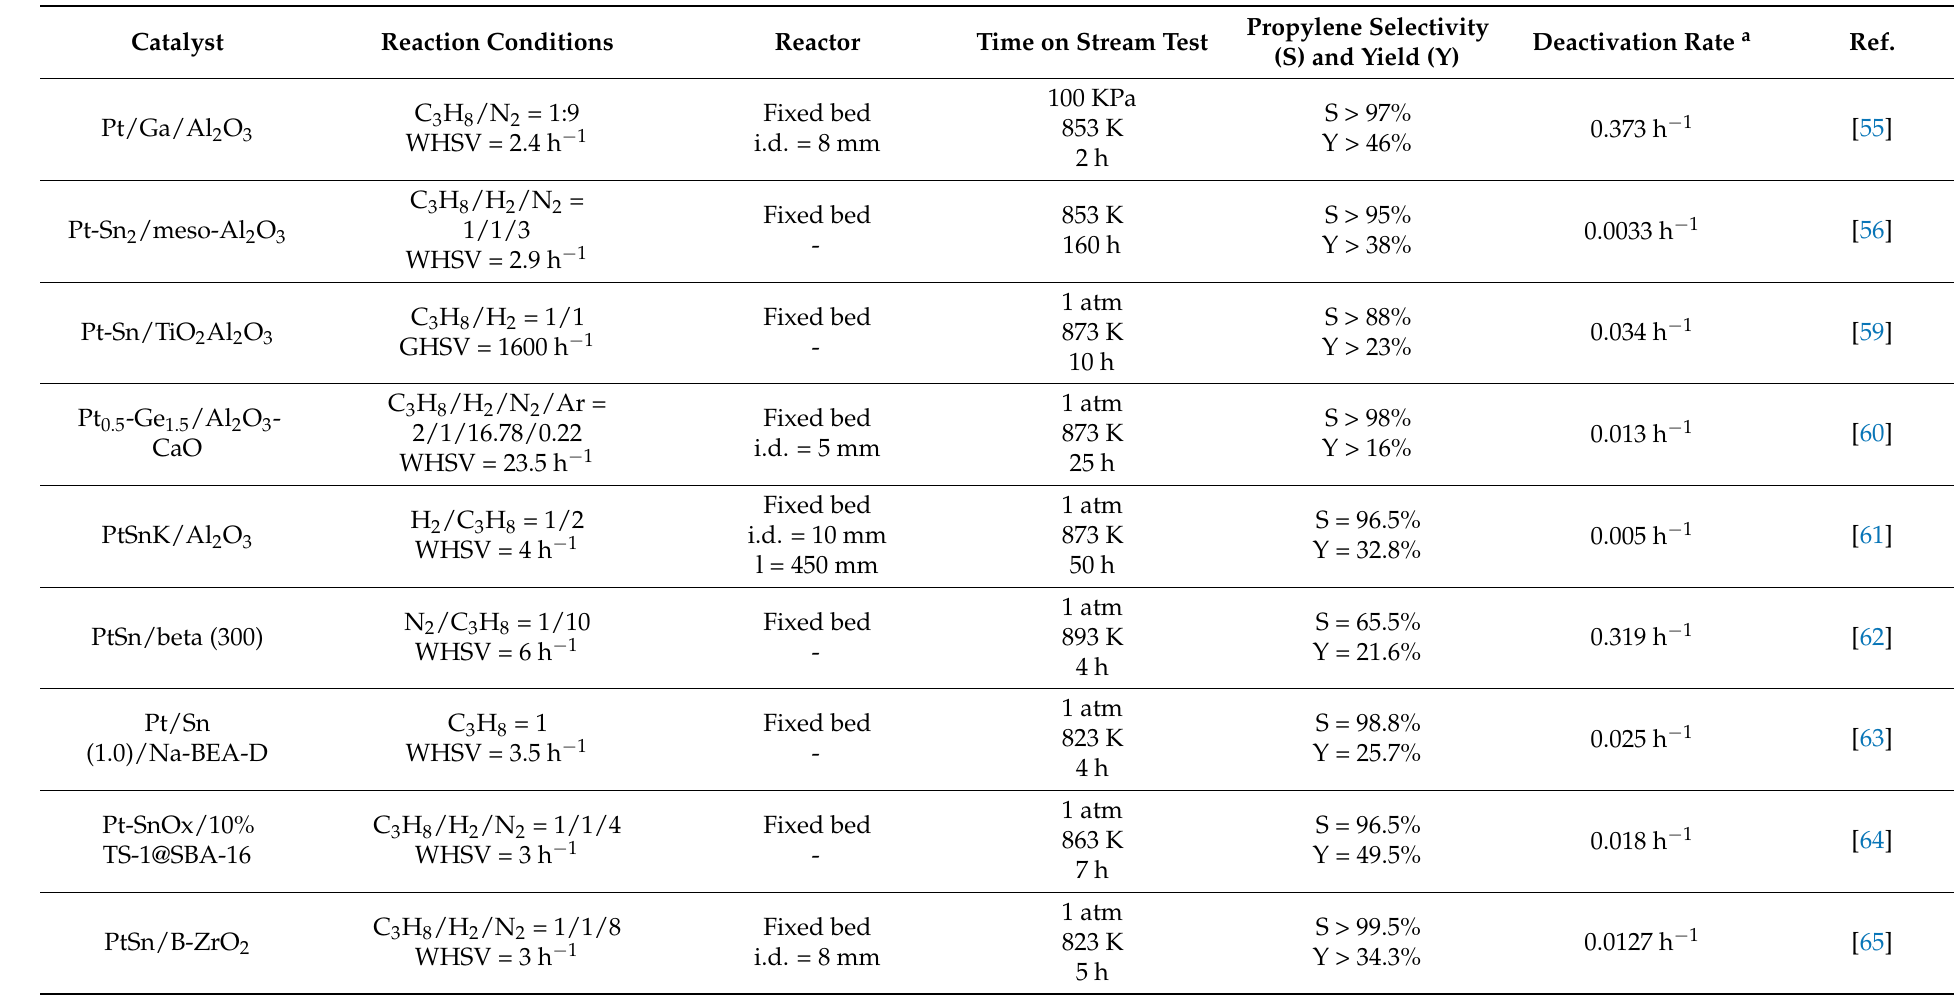
Table 2. The effect of the support: reaction conditions, propylene selectivity, propylene yield and deactivation rate per selected catalyst of each